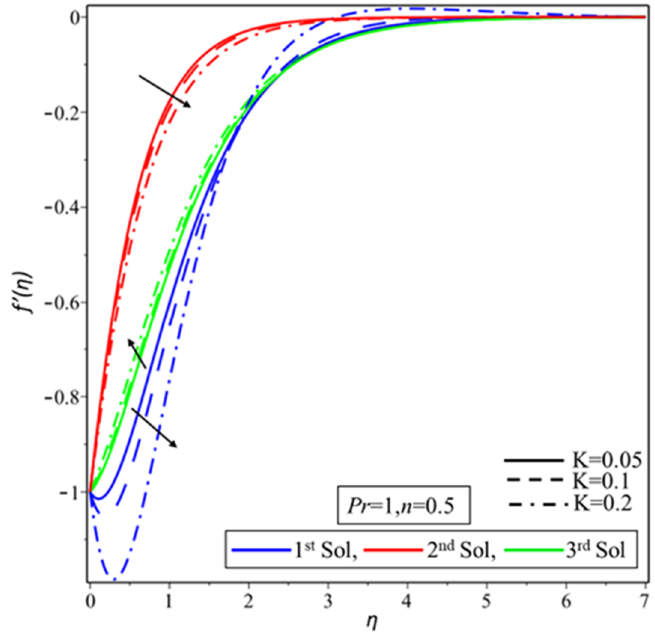
ff ect of K on f (cid:48) ( η ) when S = 2.5 . Crystals 2020 , 10 , x FOR PEER REVIEW